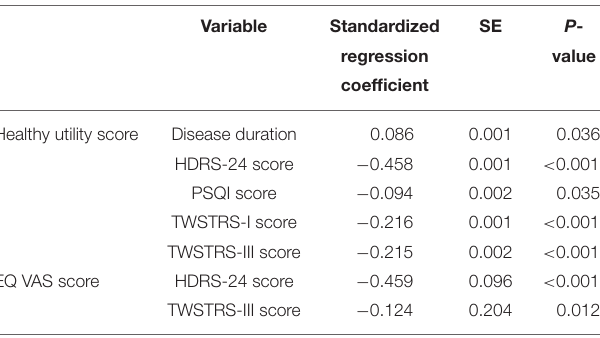
TABLE 3 | Stepwise linear regression analysis of the total EQ-5D-5L healthy utility score and the total EQ VAS score in patients with cervical